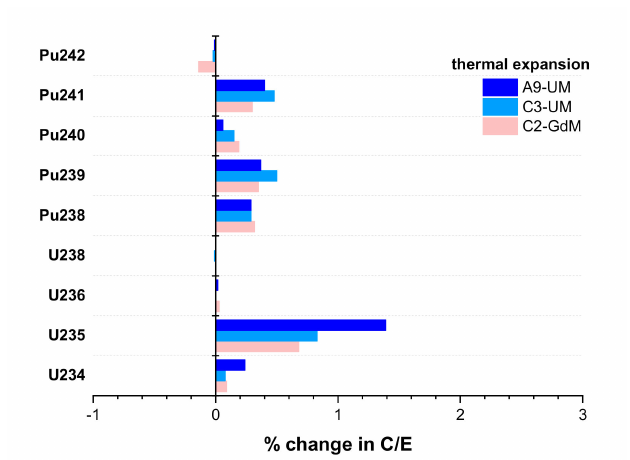
Figure 8. Change in U and Pu C/E isotope concentration ratios due to thermal expansion for samples from assembly